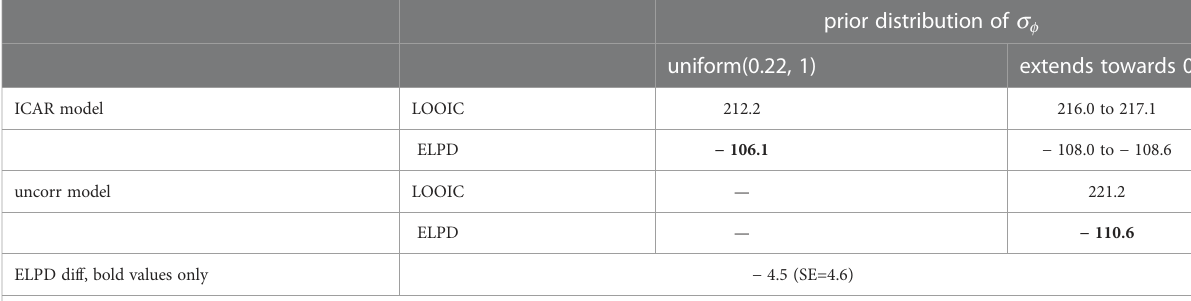
TABLE 1 LOOIC and ELPD of the ICAR and uncorrelated